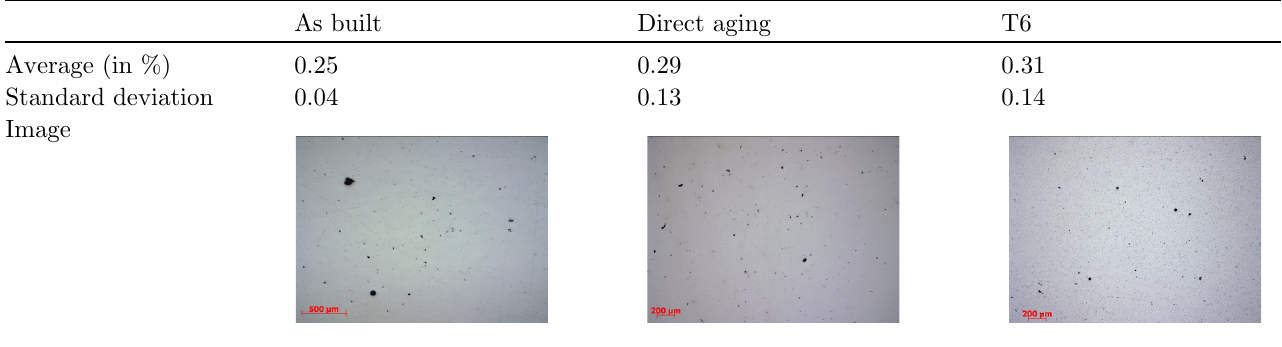
Table 2. Porosity rates by image analyses of the three